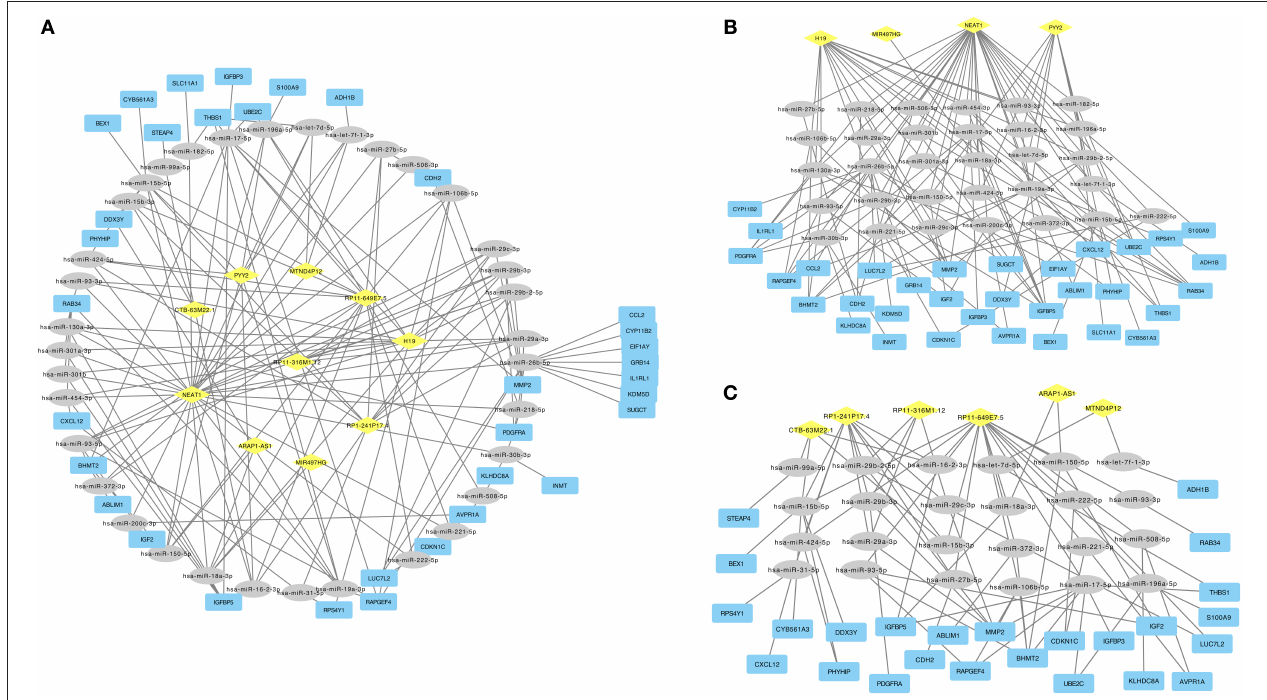
FIGURE 1 | (A) ceRNA network in ACC. Diamond in yellow represented cancer specific ceRNA. Ellipse in gray represented cancer specific mRNA. Rectangle in blue represented cancer specific mRNA. (B) Down-regulated ceRNAs regulated ceRNA network. (C) Up-regulated ceRNAs regulated ceRNA